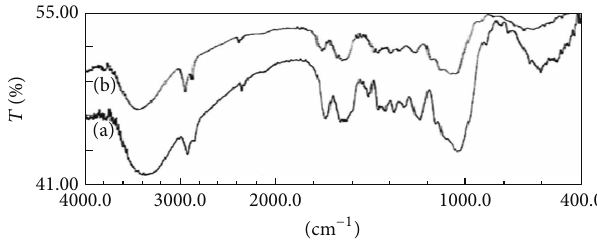
Figure 2: FTIR spectrum of IJSP alone and AB25 loaded IJSP.